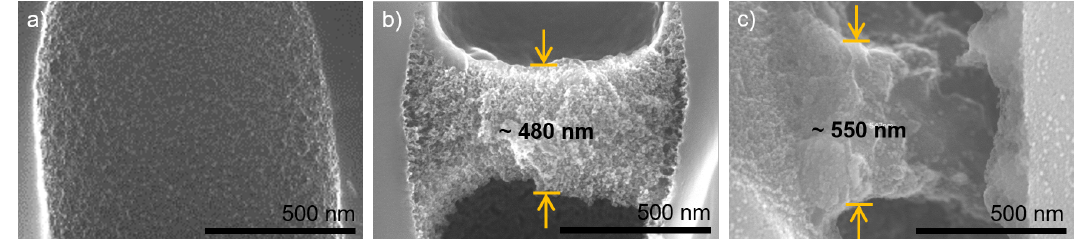
Figure 8. FESEM imaging of porous silicon support cross-sections. ( a ) no coating; ( b ) three bilayers PDADMAC/PSS with air-filled support during polyelectrolyte complexation (EDX can be found in Supplementary Materials Figure S1); ( c ) seven bilayers PDADMAC/PSS with air-filled support during polyelectrolyte